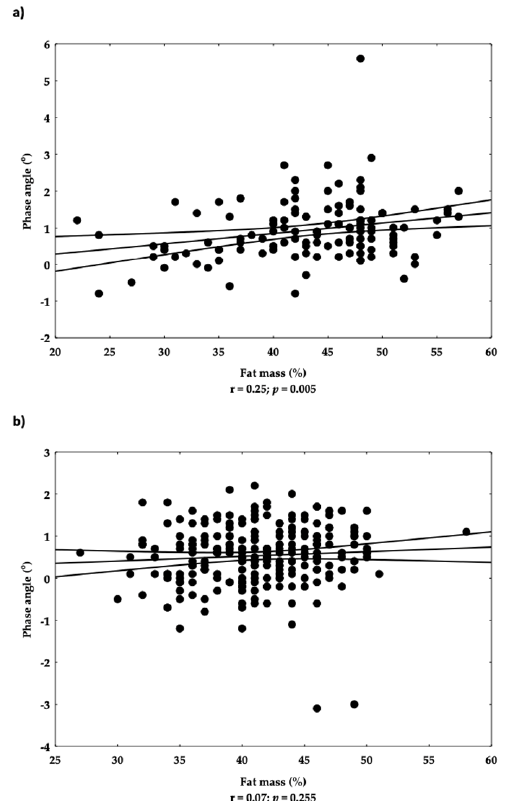
Figure 4. Correlation between fat mass (%) and phase angle in participants without ( a ) and with ( b ) osteosarcopenic adiposity (OSA). Each dot on the scatterplot presents one individual from the data set. Lines present mean and confidence intervals for orthogonal slope, level